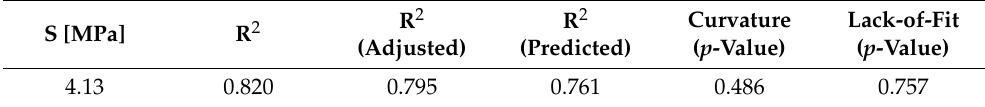
Table 3. Summary of prediction model based on